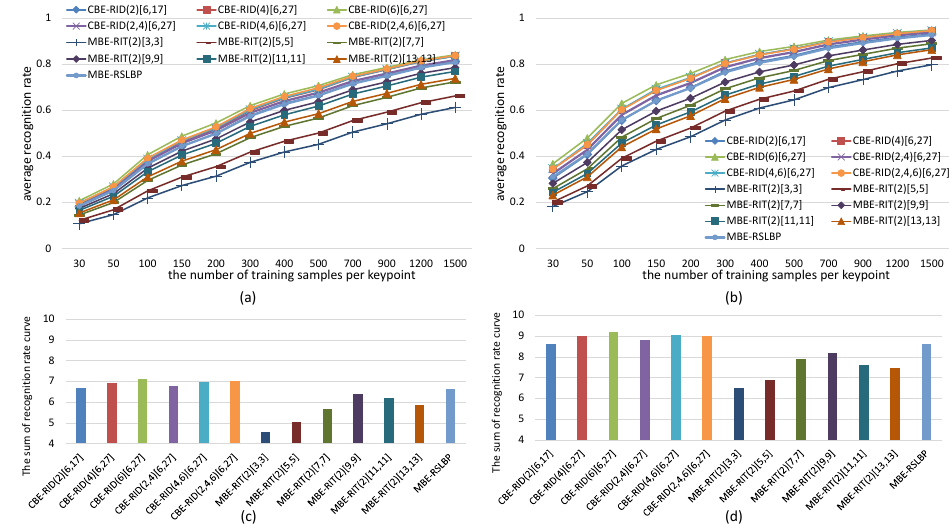
Figure 10. Average recognition rate curves of RandomTrees with respect to increasing training samples of per keypoint. Different curves represent the performance of different binary features. ( a ) Results obtained from gray images; ( b ) Results obtained from color images; Each bar of the histogram in ( c ) is calculated by accumulating the recognition rate curve of the corresponding feature method in ( a ); Similarly, ( d ) is calculated from ( b ). The histograms show the performance rank of compared